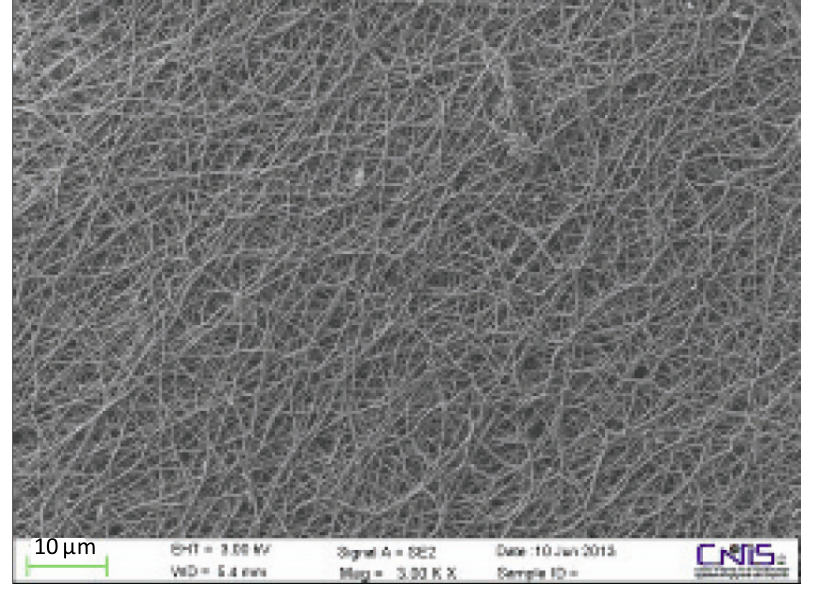
Table 2. Comparison of SPF and UVA-PF activity of chitin nanofibrils-hyaluronan entrapping carotenoids, ZnO and TiO ( p < 0.005) and significant as each other groups. Zn = zinc oxide nanoparticles; TiO